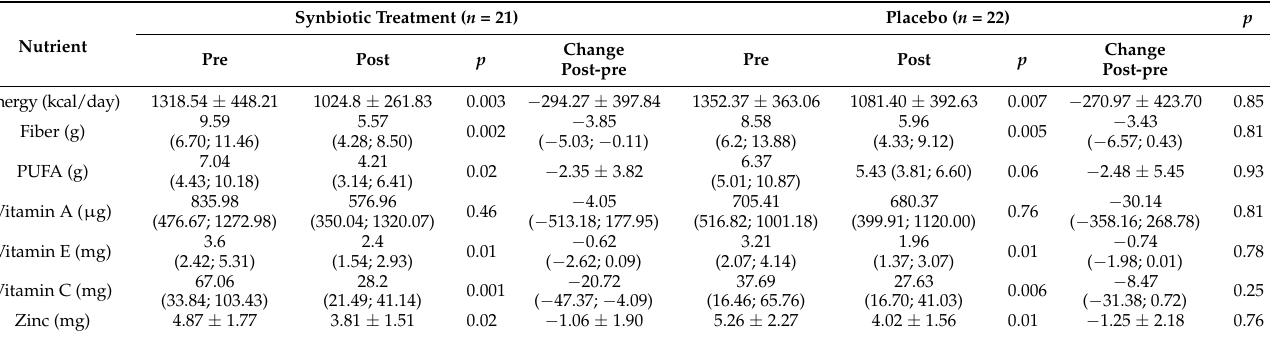
Table 2. Daily intake from food